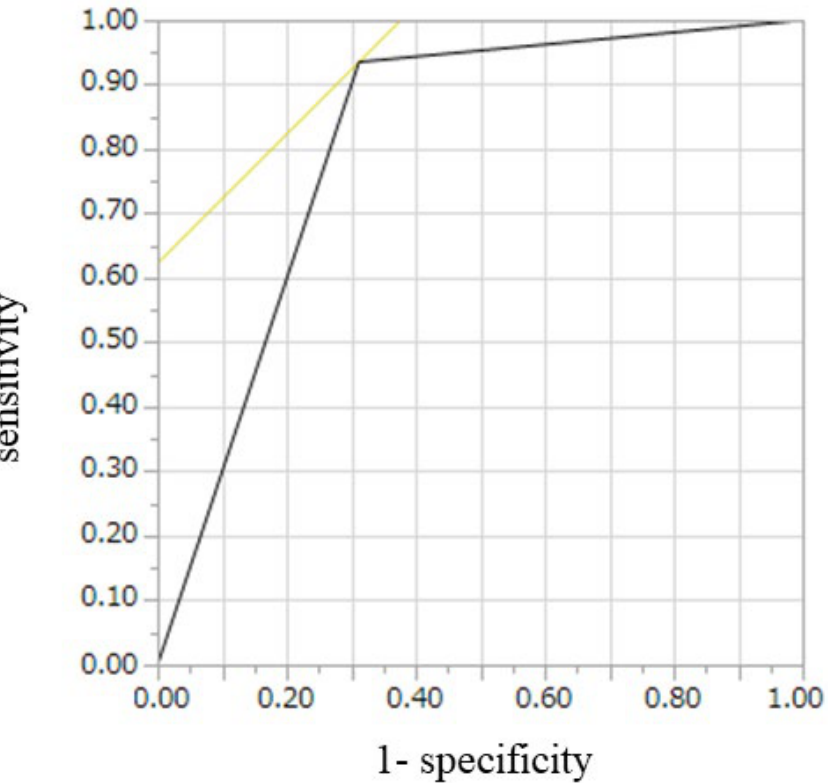
Figure 2. Receiver operating characteristics curve for diagnosis of GIST on CH-EUS. GIST, gastrointestinal stromal tumor; CH-EUS, contrast-enhanced harmonic endoscopic ultrasound.